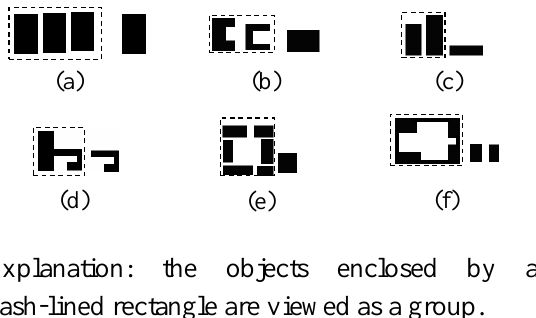
Fig.1 Objects on maps are viewed as a group in light of the Gestalt Fig. 1. Objects on maps are viewed as a group in light of the gestalt principles: (a) proximity; (b) similarity; (c) similar direc- tion; (d) connectedness; (e) closed tendency; and (f) same